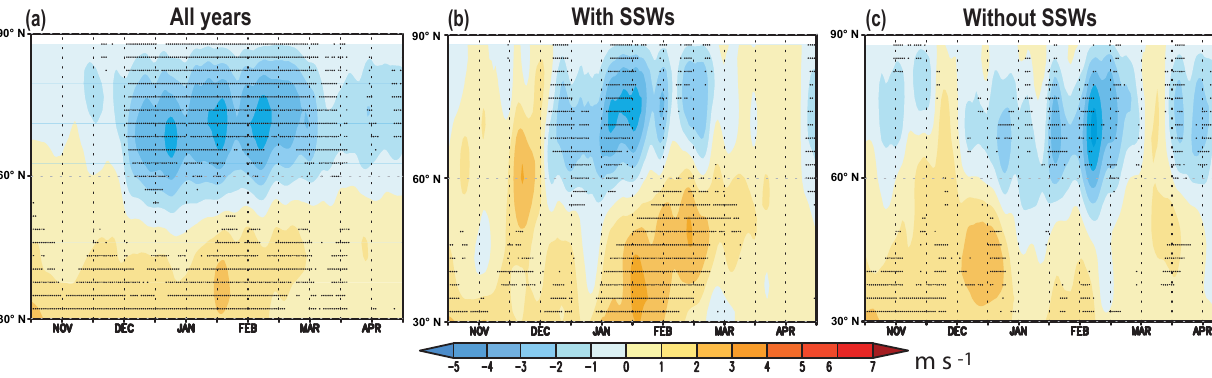
Figure 4. (a) Multi-model mean of future-minus-past differences in the daily climatology of 5-day running mean of zonal-mean zonal wind at 10hPa. (b) Same as (a) but only for winters with SSWs. (c) Same as (a) but for winters without SSWs. Shading interval: 1ms − 1 . Dots indicate where at least 75% of the models coincide in sign with the multi-model